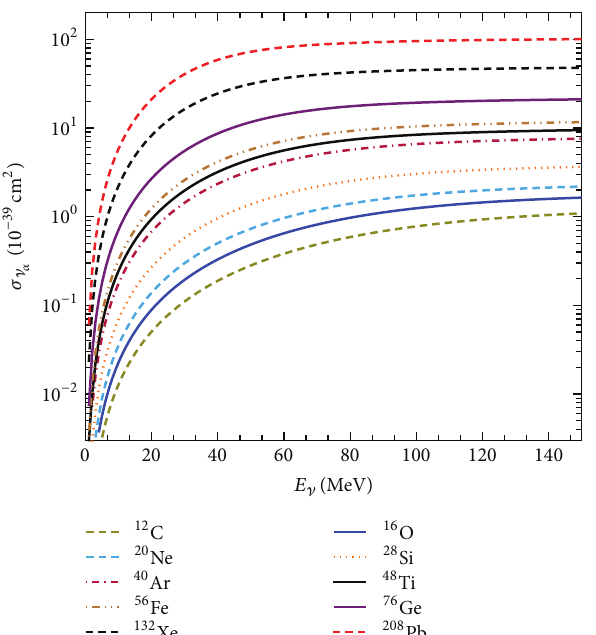
(𝐸 ) in units 10 −39 cm 2 for a set of nuclei as a function of the incoming neutrino energy 𝐸 ] 𝛼 (̃ ] 𝛼 )